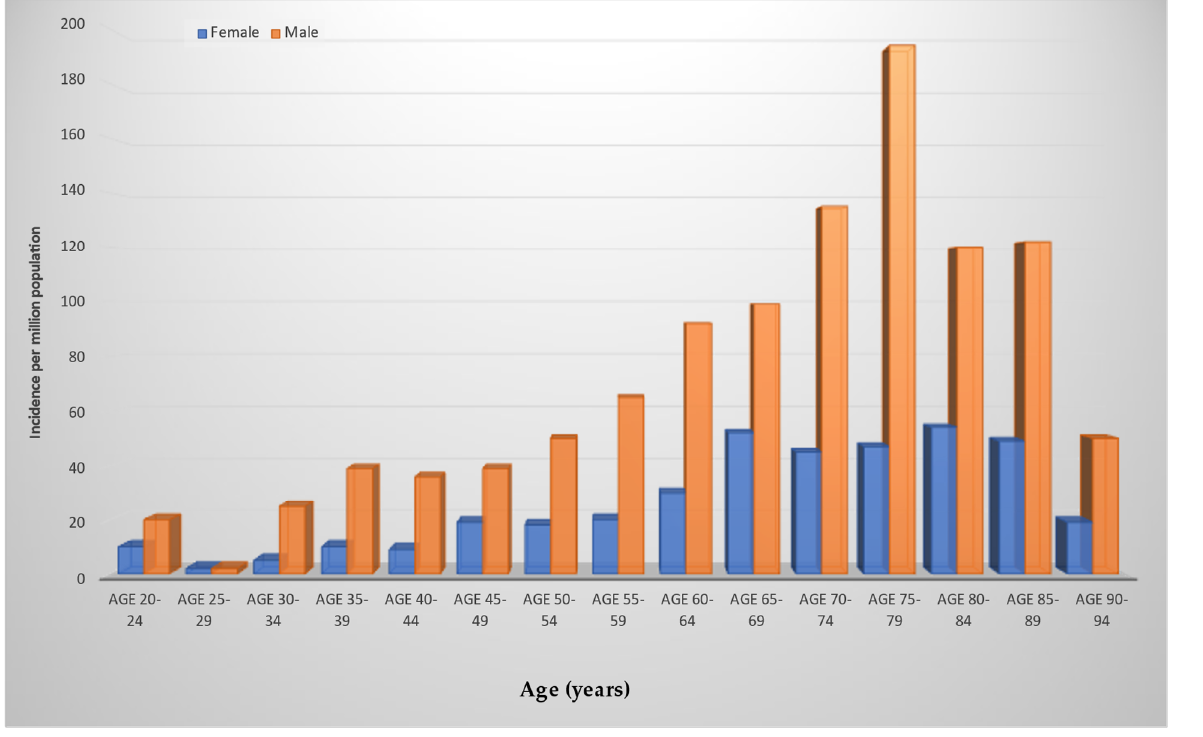
Figure 2. Depiction of the incidence of infective endocarditis according to age and sex. The incidence peak was reported as 194 cases per million in a population of men with IE aged 75–79 years. Blue box, female; dark yellow box, male.